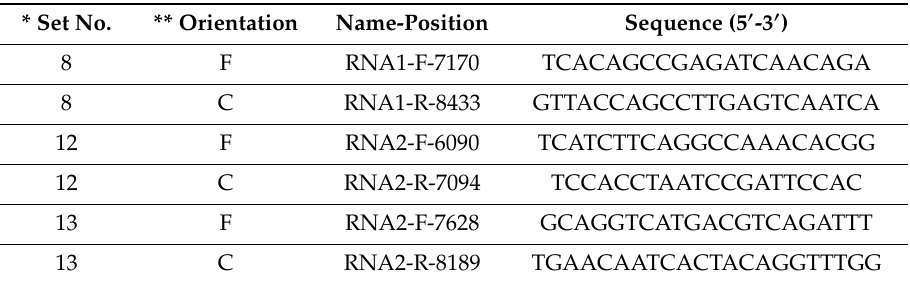
* Primer set numbers are based on Table S1. ** F = forward, C = complement.